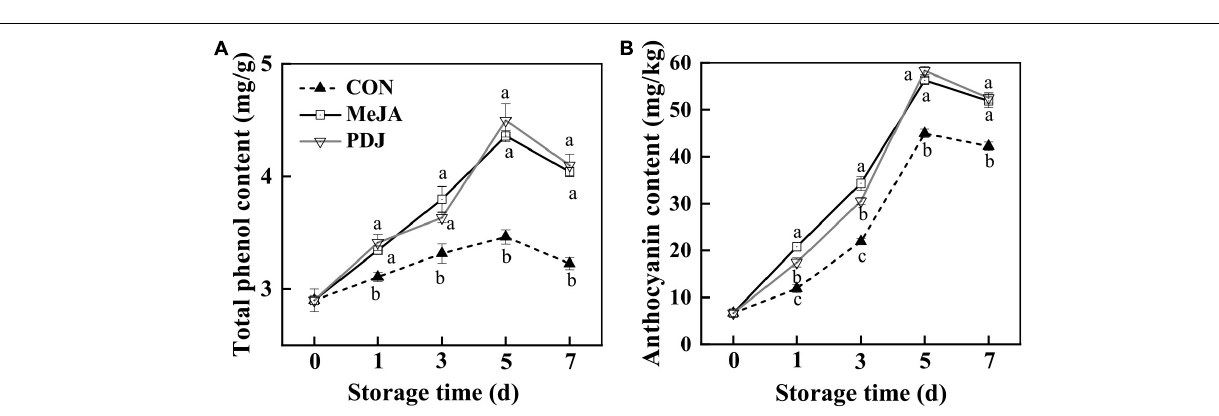
FIGURE 3 | Effects of postharvest jasmonate treatments on TPC (A) and anthocyanins (B) in the skin of peach fruits during storage (22 ± 2 ◦ C; light intensity 300–400 lux). Different lower-case letters indicate significant differences ( P < 0.05) from three treatments at the same time